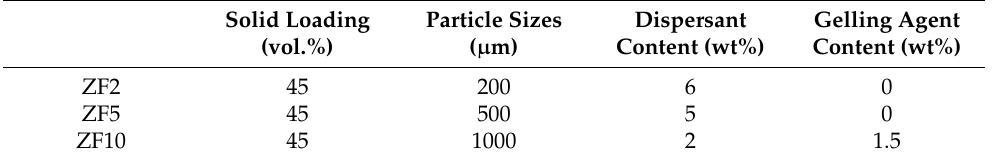
Table 3. Slurry composition for printing. Solid Loading